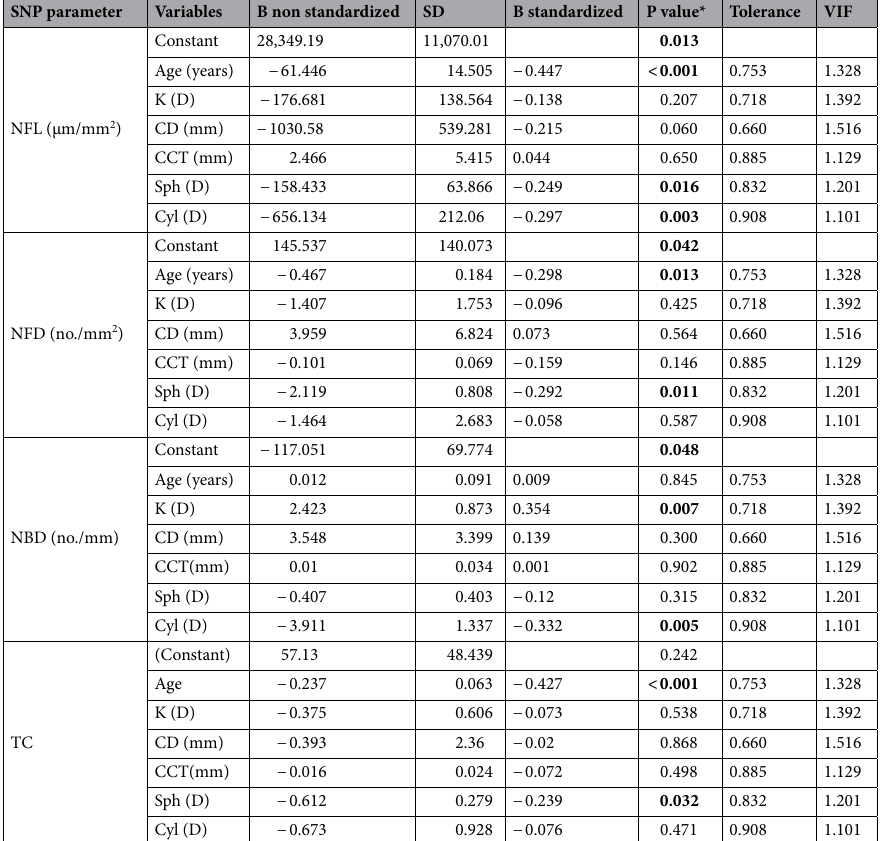
Table 5. Multiple regression model—dependent variable NFL, NFD, NBD and TC*. * NFL nerve fiber length (µm/mm 2 ), NFD nerve fiber density (no./mm 2 ), NBD nerve beadings density (no./mm), TC tortuosity coefficient, K corneal curvature ( D diopter), CD corneal diameter (mm), CCT corneal thickness (µm), Sph sphere ( D diopter), Cyl cylinder ( D diopter). **Bold values denote statistical significance at the p-value < 0.05.